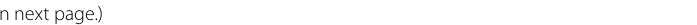
figure on next Fig. 1 Protein–protein interaction (PPI) network created using STRING. The nodes represent proteins and the edges represent protein–protein association. The edge confidence is set to high (0.700), and disconnected nodes are hidden in the network. The nodes common to the most enriched pathways, i.e., substance abuse receptors and neuroactive ligand–receptors, are highlighted. Nodes in blue represent nicotine addiction, nodes in green represent cocaine addiction, nodes in yellow represent morphine addiction and nodes in red represent neuroactive ligand–receptor interaction. The edges are coloured based on the following types of interactions: known interactions (turquoise—from curated databases, purple— experimentally determined), predicted interactions (bright green—gene neighbourhood, red—gene fusions, dark blue—gene co-occurrence) and others (yellow—text mining, black—co-expression, light blue—protein homology).The filled nodes show that the 3D structure of the protein is known or